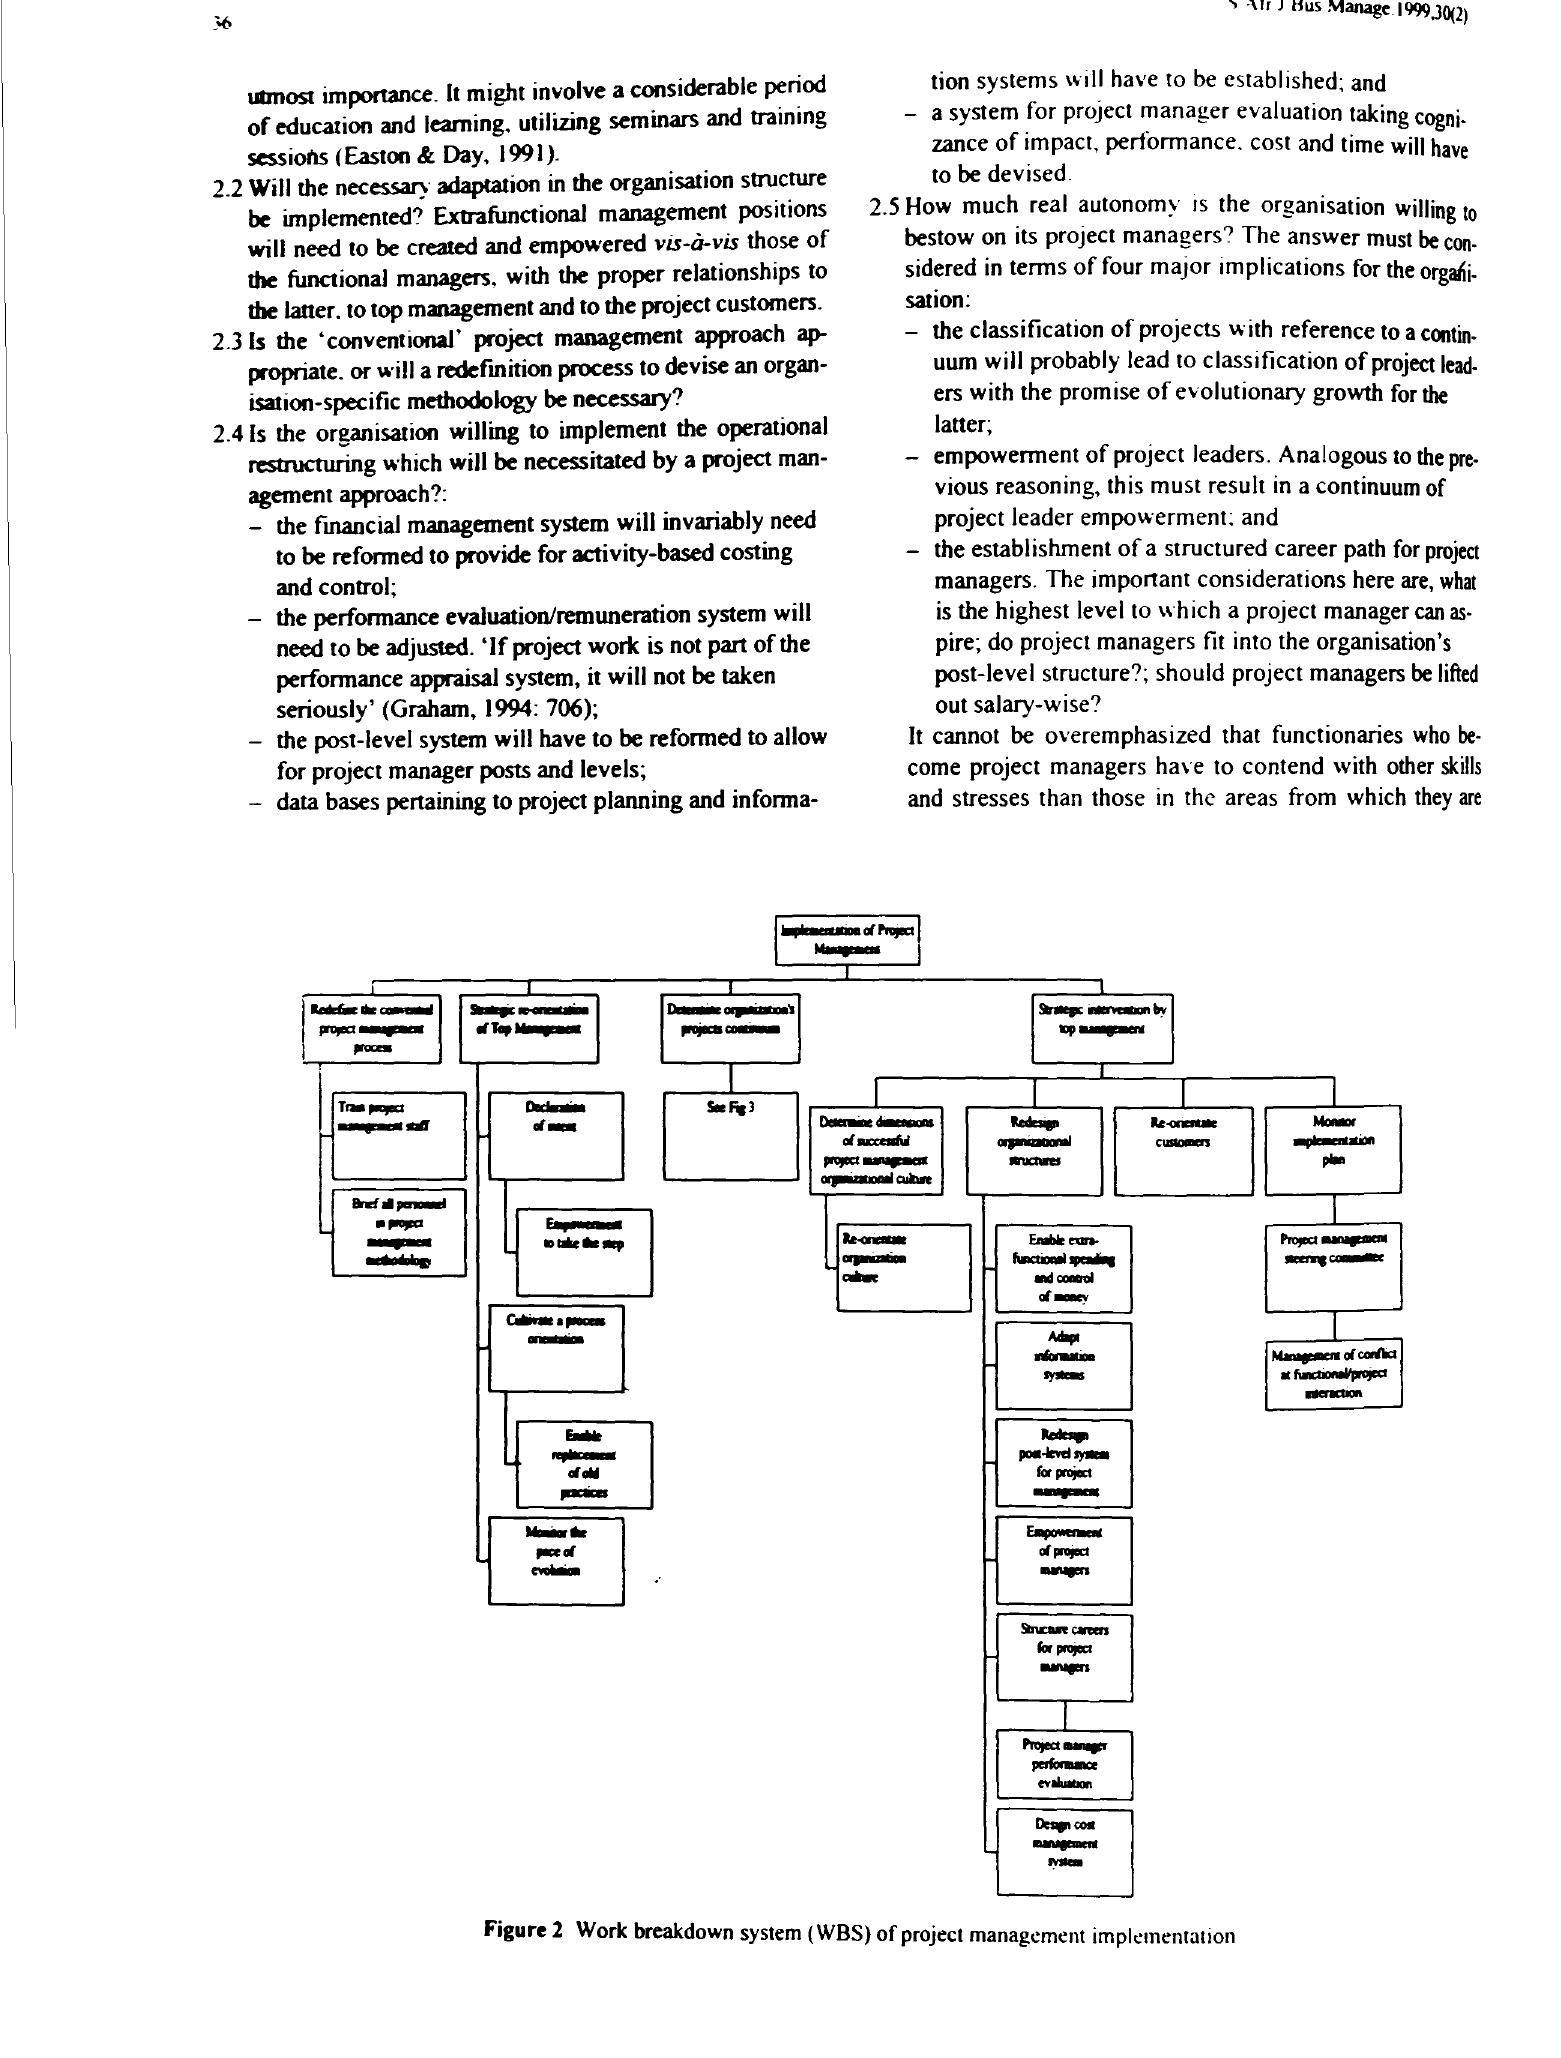
Figure 2 Work breakdown system ( WBS) of project management